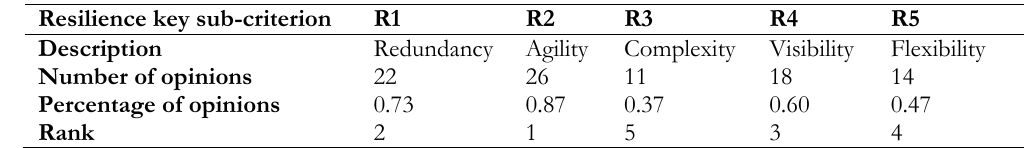
Table 16. Percentage of opinions and rank of each sub-criterion.